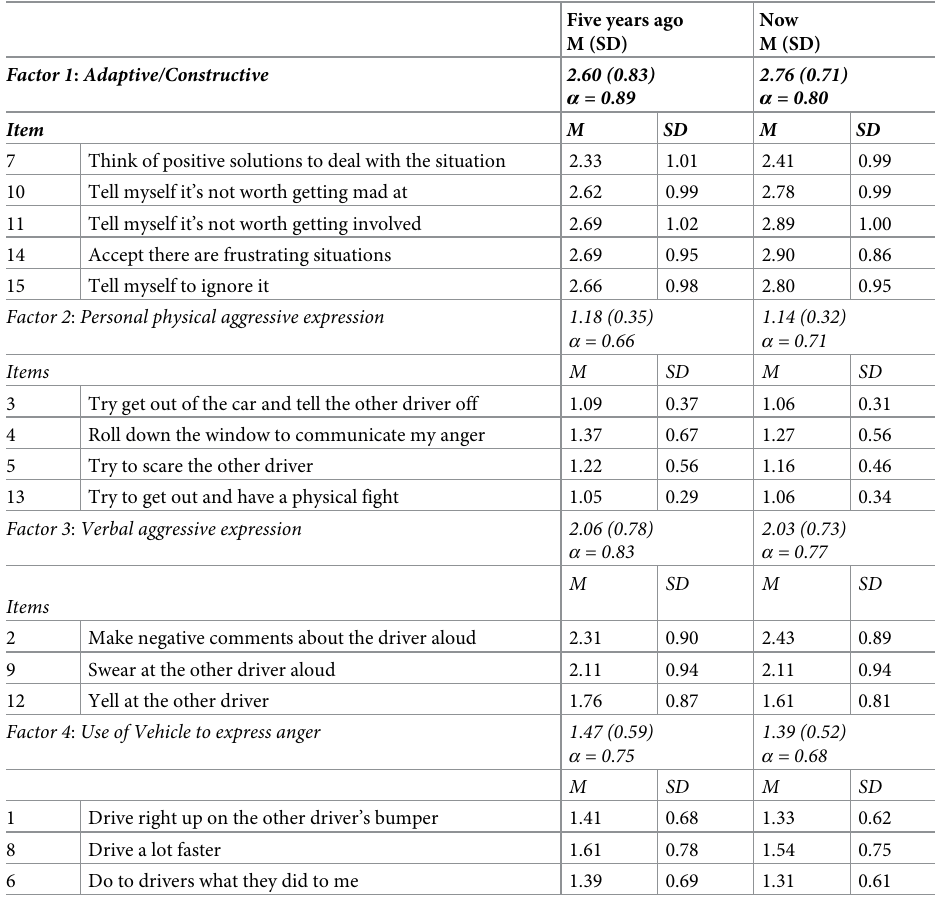
Table 2. Means and SD of driving anger expression items now and five years ago (n =